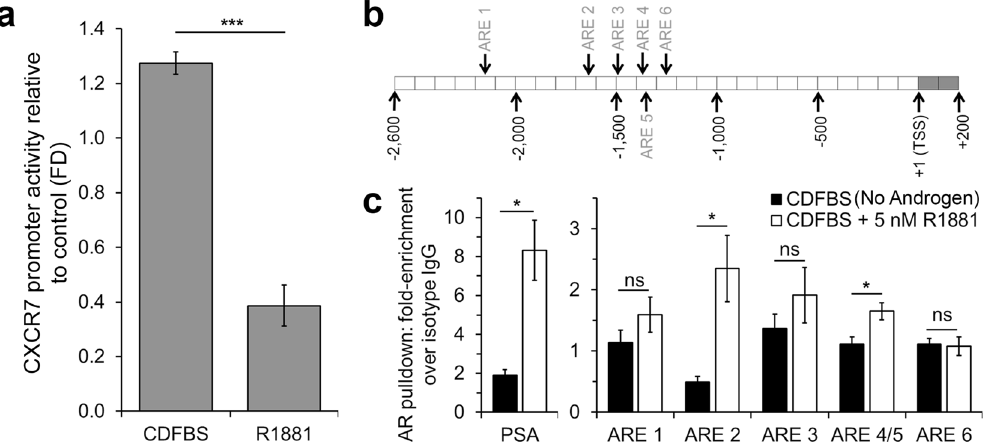
Figure 3. CXCR7 expression is directly regulated by AR binding to the CXCR7 promoter. ( a ) CXCR7 promoter-driven luciferase activity in C4-2B cells cultured in CDFBS ± R1881, relative to untreated control cells (n = 3, mean ± SEM). ( b ) Diagram of the cloned CXCR7 promoter region including the 6 putative AREs tested for AR binding. ( c ) ChIP assay for AR pulldown of promoter regions shown in B in LNCaP ± R1881. The PSA enhancer region served as a positive control for AR binding. n = 3, mean ± SEM; * p < 0.05, *** p < 0.001, ns = no significance; unpaired, two-tailed Student’s t-test.